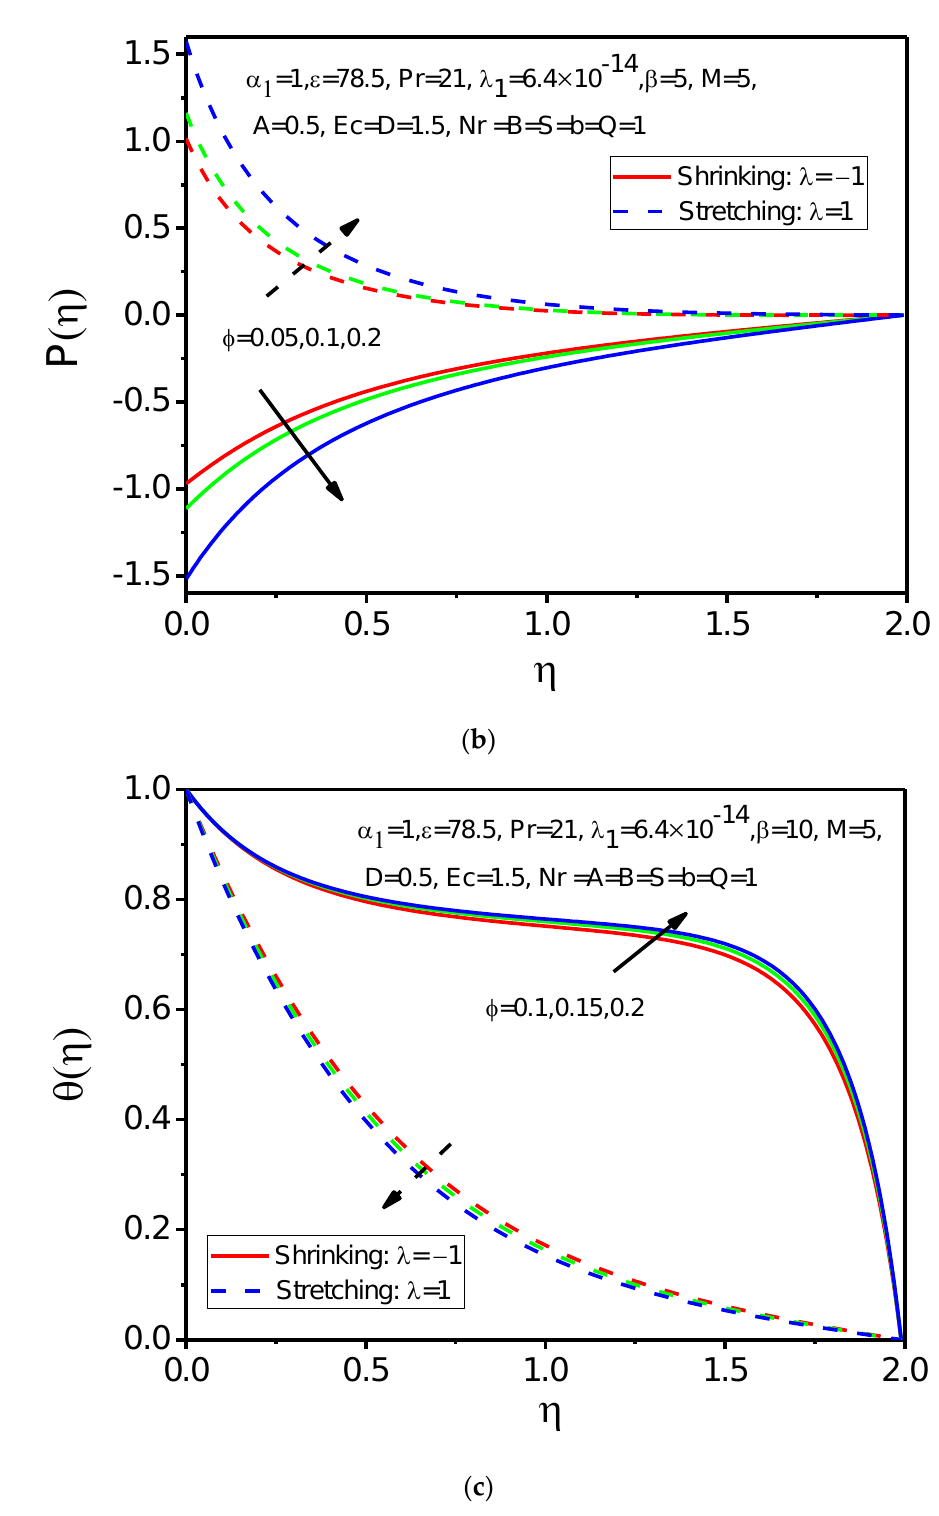
Figure 8. Variation of  on ( a ) Velocity profile, ( b ) Pressure profile, ( c ) Temperature profile. Figure 8. Variation of φ on ( a ) Velocity profile, ( b ) Pressure profile, ( c ) Temperature Figure 9 represent the variation of unsteadiness parameter on velocity, pressure and temperature profiles. Where Figure 9a captures the influence of the unsteadiness param- eter on the axial velocity profile for the combination of stretching and shrinking configu- ration. It can be observed from this Figure that the velocity profile decreases when the values of A are enhanced and it is happening only for the stretching case. The reverse trend is observed for the shrinking mode. This is happening because of the existing corre- a lation between the positive constant and the unsteadiness parameter A . The en- a hancement of positive values flourished A , which consequently increases the stretch-